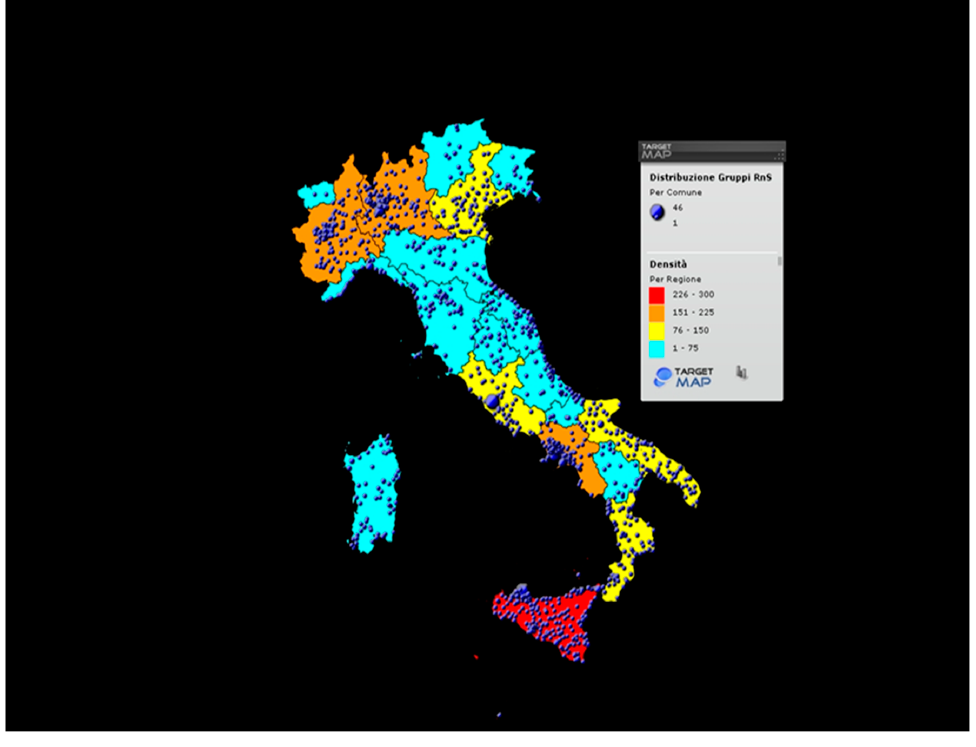
Figure 1. The RnS communities in Italy.